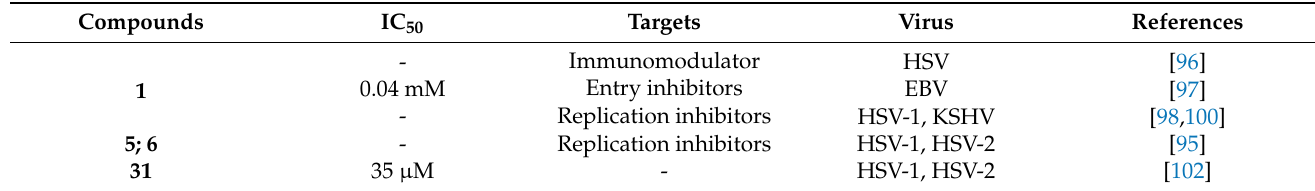
Table 8. Summary of anti-herpes-virus triterpenoids and their targets and activities.